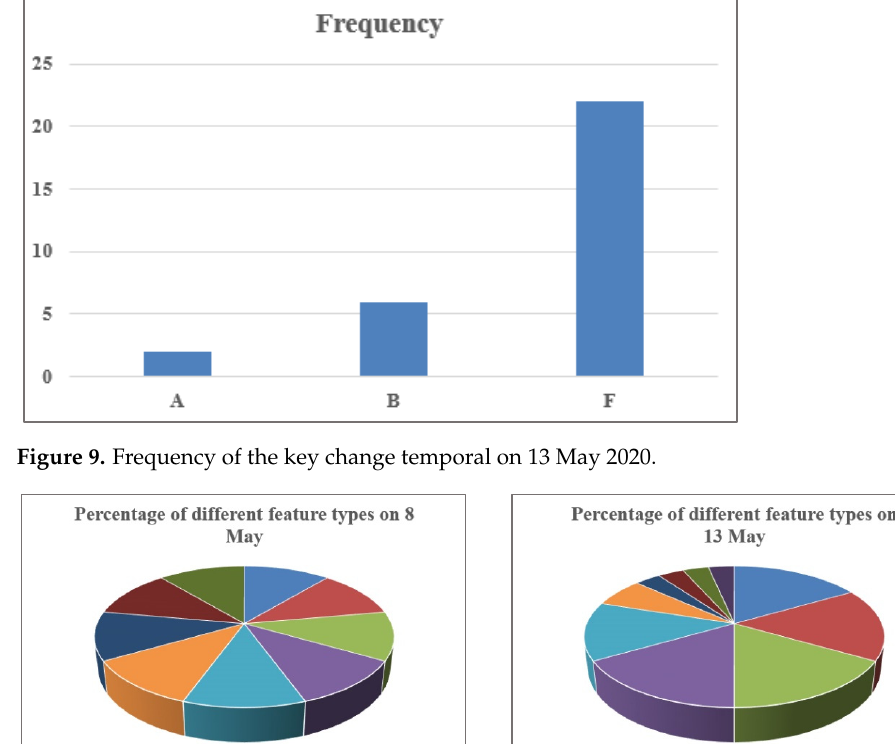
Figure 9. Frequency of the key change temporal on 13 May 2020.